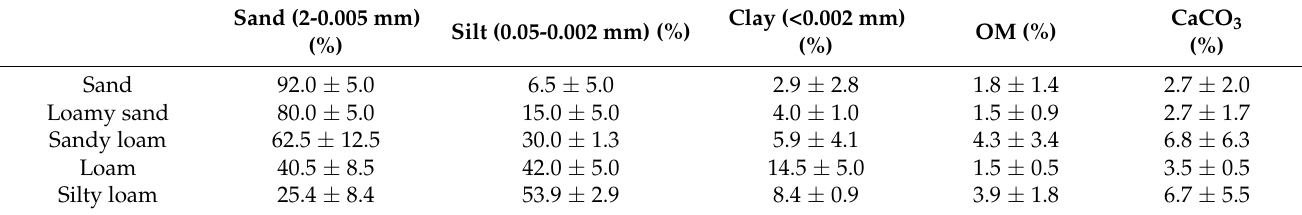
Table 2. Particle-size distribution and chemical properties of soils samples. OM: organic matter (mean ± standard deviation). Sand (2-0.005 mm) Silt (0.05-0.002 mm) (%)